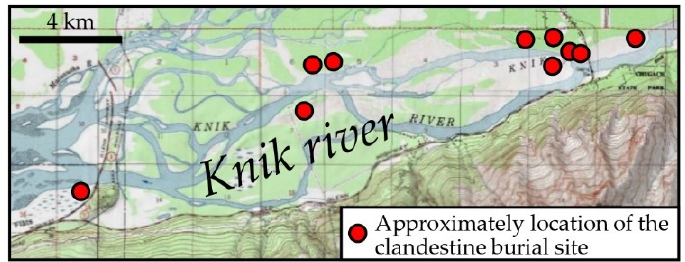
Figure 2. Map of the Knik River (Alaska) showing the localization of the clandestine graves dug by the serial killer Robert Hansen in the river alluvial deposits.